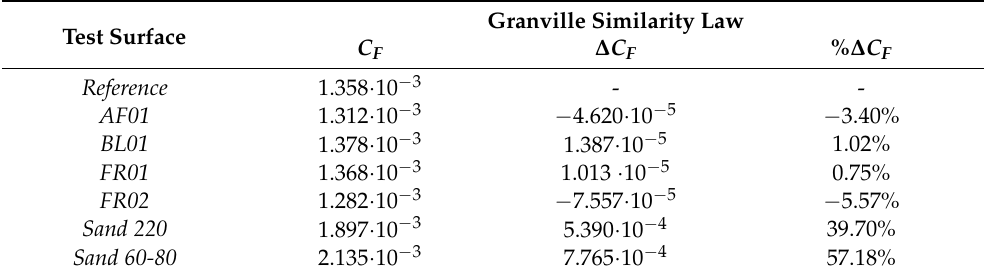
Figure 13. Frictional and total resistance coefficients variation in different hull roughness conditions. Figure 14. Frictional and total resistance coefficients variation in different hull roughness condi- tions. Table 8. Frictional resistance results ( C F ) results on the full-scale KCS hull at 24 knots ( Fn = 0.26 ). Test Surface